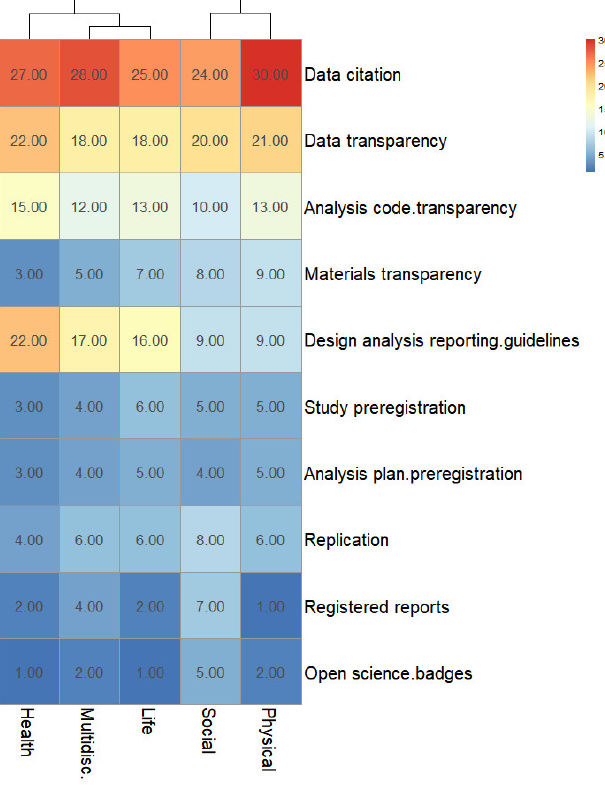
Figure 3. Heatmap of the percentage of discipline-specific journals that adopt each individual TOP standard. Statistics are reported per column (e.g., column’s values sum up to 100).